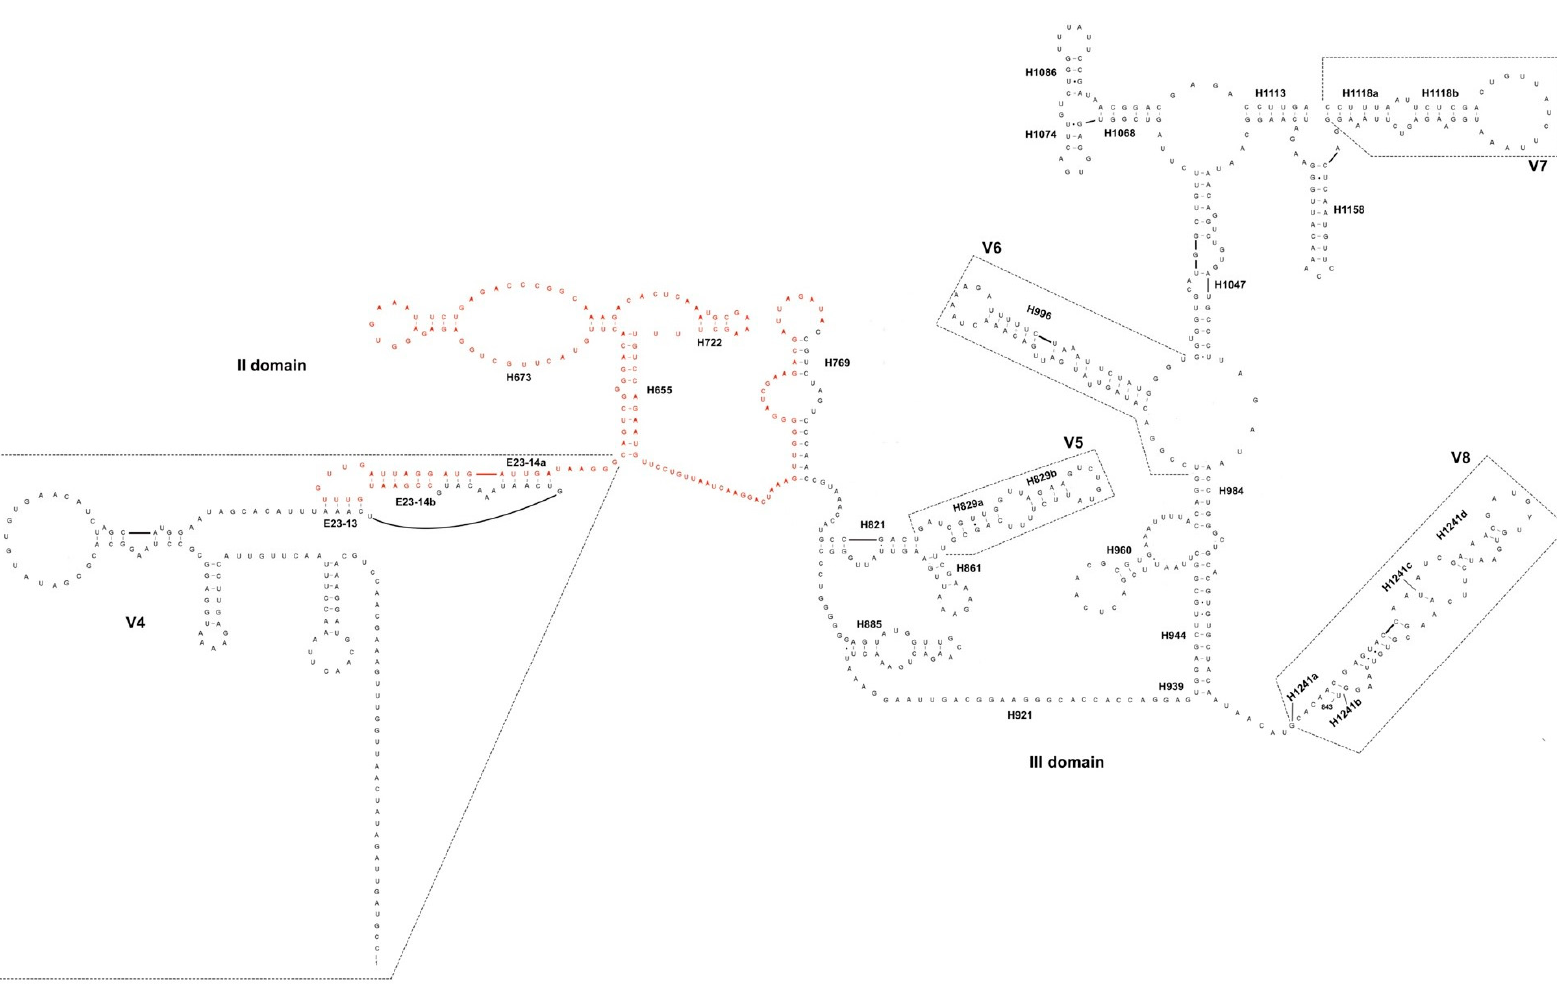
Figure 2. The II and III domains of the 18S secondary structure of gregarines isolated from T. molitor and Z. atratus midgut. In red, the portion of the rDNA fragment missing in the gene “variant” detected in Z. atratus . Nomenclature of helices and variable regions as in [24].